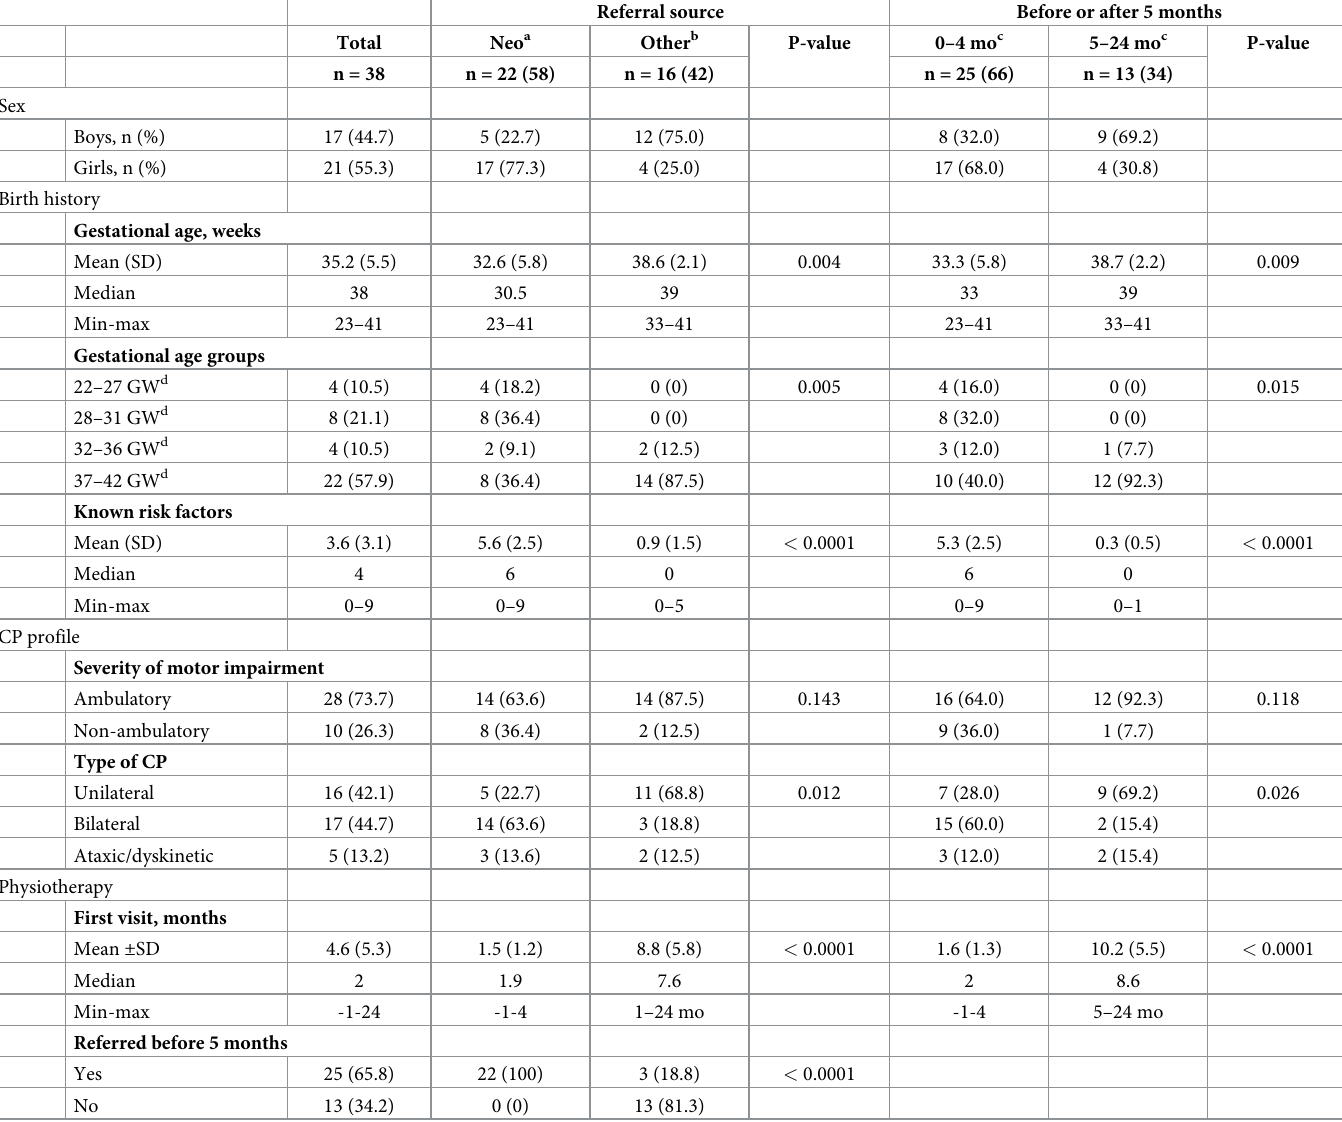
Table 1. Descriptive statistics for all children with cerebral palsy (CP) as well as divided by referral source and referred before or after 5 months corrected age. Referral